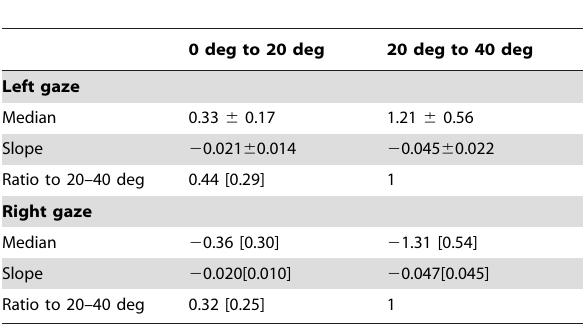
Table 1. Summary of the drift velocity and the slopes estimated from single subjects.